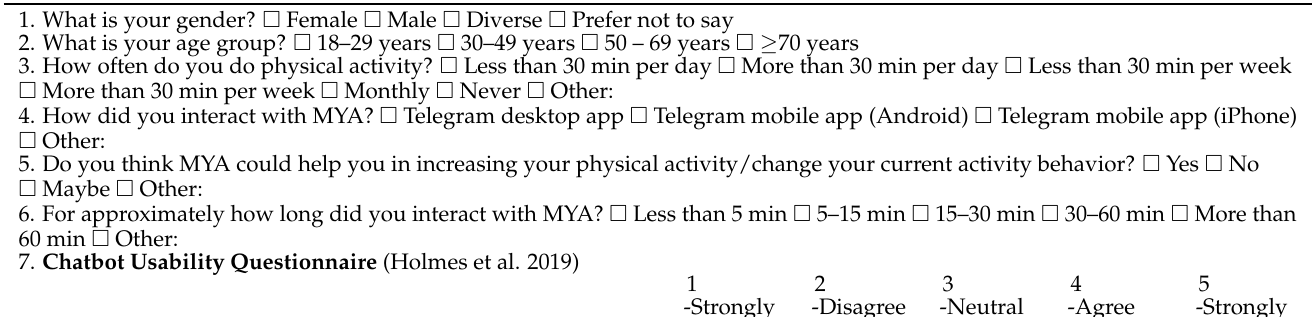
Table A1. MYA Usability Testing